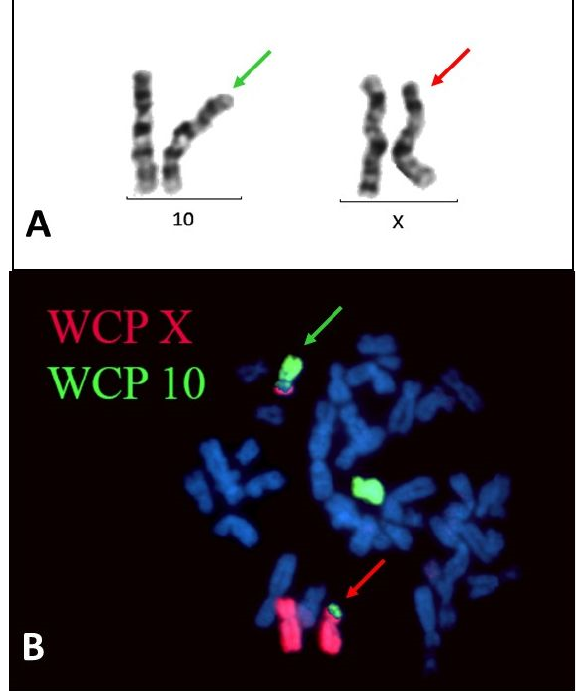
Figure 1. G-banding ( A ) and FISH pattern ( B ) of the t(X;10)(p21.1;p12.1) translocation. In the FISH image, the X chromosomes are visualized by red and chromosome 10 by green whole chromosome painting probes (WCP). The red arrows indicate the derivative X, whereas the green arrows the derivative 10